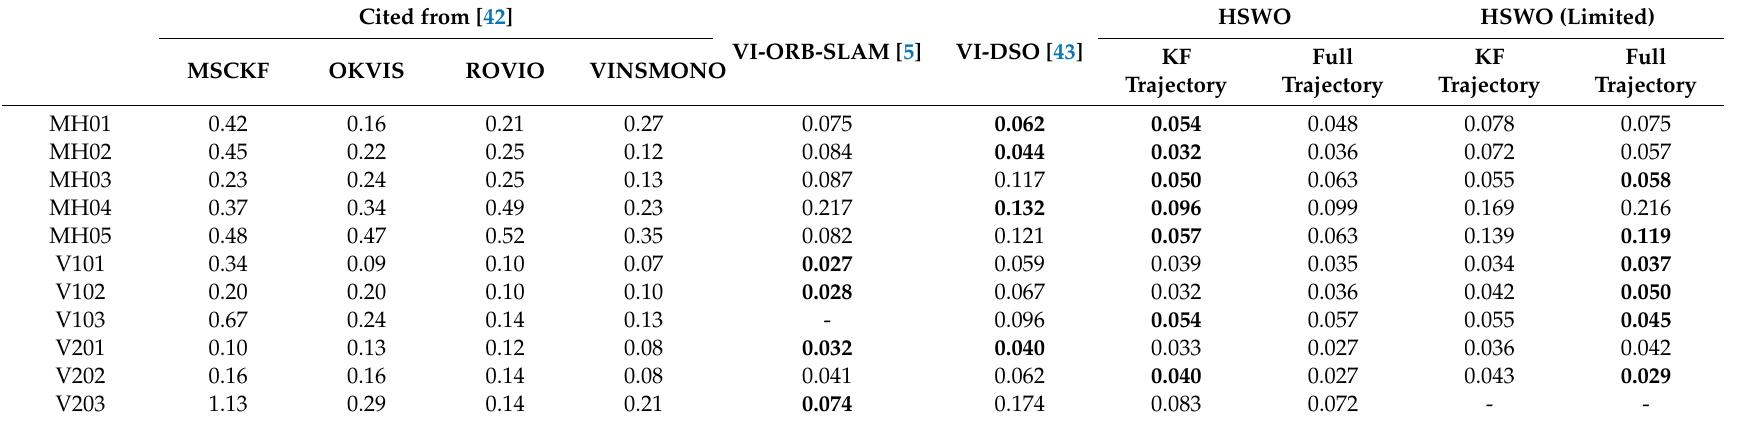
Table 2. RMSEs of absolute metric position errors (m) on the EuRoC